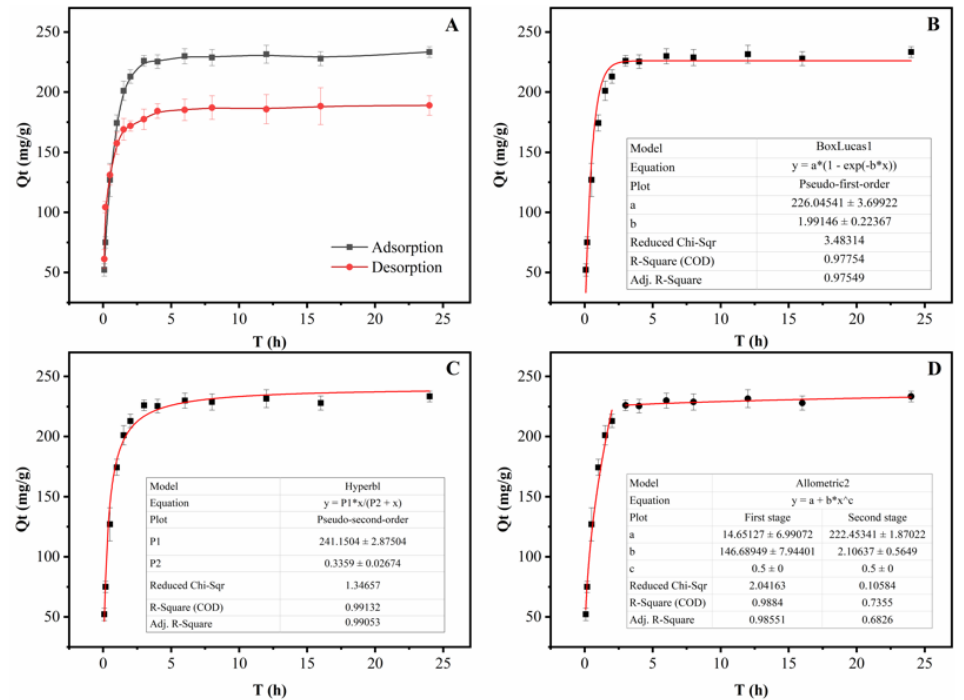
Figure 2. Adsorption / desorption kinetics for the total polymethoxyflavones on CNPC1 ( A ) and the simulation of PMF adsorption into the CNPC1 using the pseudo-first-order kinetic model ( B ), pseudo-second-order kinetic model ( C ), and intraparticle diffusion model ( D ).